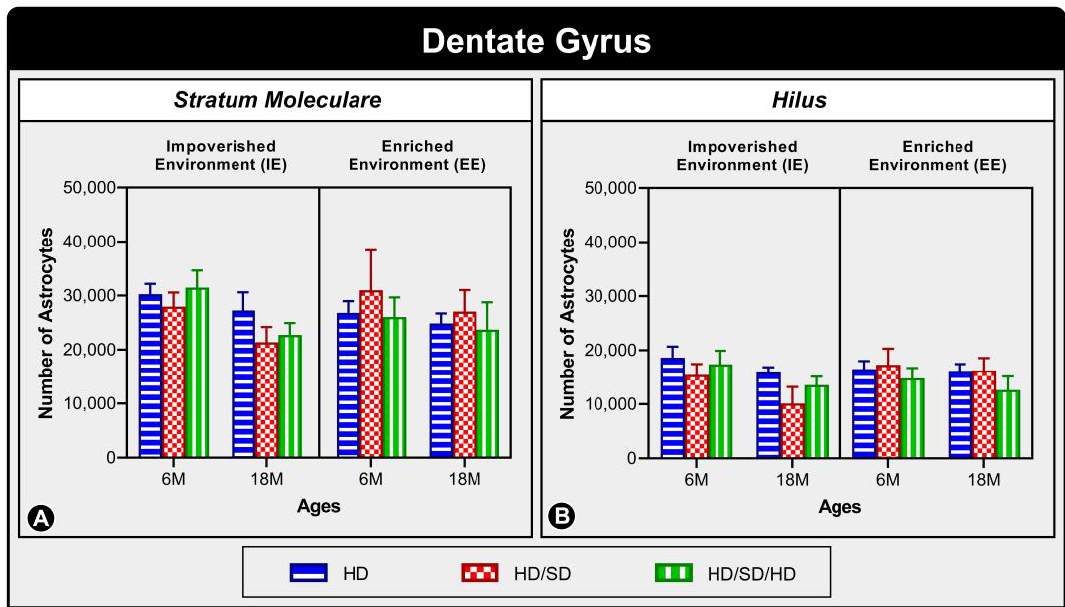
Figure 1. Graphical representation of astrocyte numerical estimation in the dentate gyrus (DG) under the influence of environment, age, and diet regimen. The graph compares the amount of astrocytes present in S. Moleculare ( A ) and Hilus ( B ) of DG in the 6-month-old age group (6M) and 18-month-old age group (18M) reared in standard, impoverished environment (IE), and enriched environment (EE), and submitted to one of three types of diet: HD, hard diet (in blue) = pelleted chow, HD/SD, hard diet/soft diet (in red) = pelleted and mash ration; and HD/SD/HD, hard diet/soft diet/hard diet (in green) = pelleted/powdered/pelleted feed. In this graph, no statistically significant differences were found between the investigated